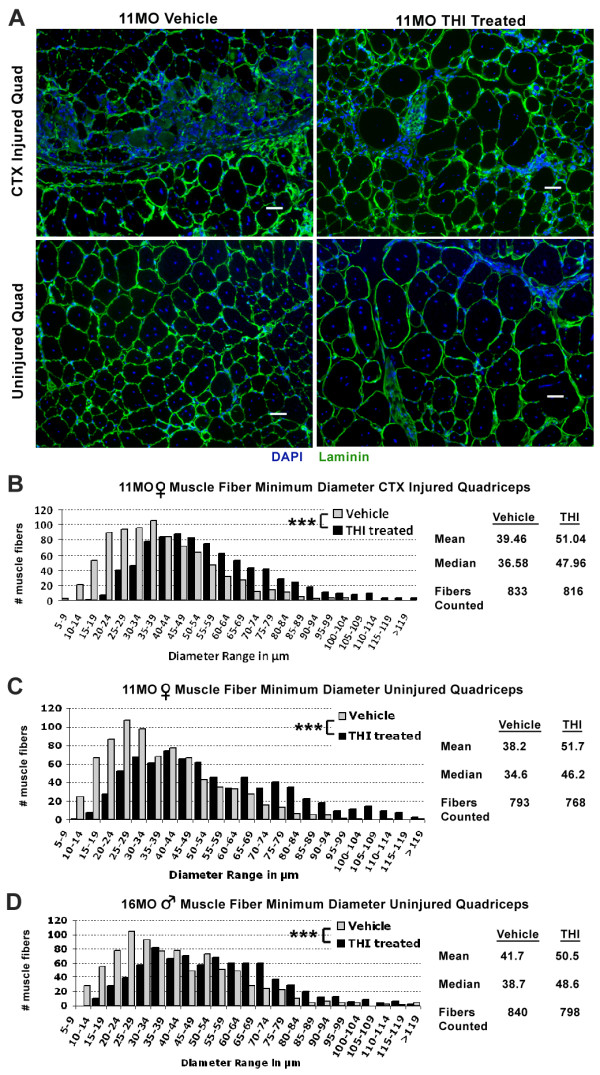
Elevating S1P levels with THI increases muscle fiber size. (A) Staining for laminin (green) and DAPI (blue) depict a dramatic increase in muscle fiber size in both injured and uninjured quadriceps (quads) with THI treatment. Depicted are quadriceps muscles from 11-MO mdx4cv mice. Scale bars = 50 μm. (B,C,D) Quantification of minimum muscle fiber diameter reveals a significant increase in myofiber size in THI-treated animals. Increased myofiber diameter was observed in both (B) injured and (C) uninjured quadriceps from THI-treated 11-MO mdx4cv mice, whereas only (D) uninjured quadriceps in THI-treated 16-MO mdx4cv mice showed increased myofiber size compared to vehicle controls. As indicated by the distributions, mean and median values of muscle fiber minimum diameters, there is an overall increase in muscle fiber size with THI treatment. Quantifications were undertaken in random fields in both injured and uninjured muscles in order to obtain an overall representation of fiber size increase for each muscle.*P <0.05, ***P <0.0005 by student’s t-test. Error bars represent SEM. DAPI, 4',6-diamidino-2-phenylindole; MO, month-old; S1P, sphingosine-1-phoshate; SEM, standard error of the mean; THI, 2-acetyl-4(5)-tetrahydroxybutyl imidazole.